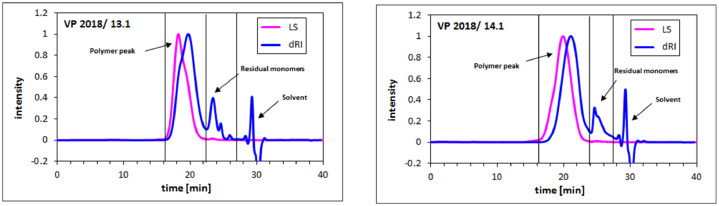
SEC spectra of the BASF PCE superplasticizers; eluent: 0.1 M NaNO3.